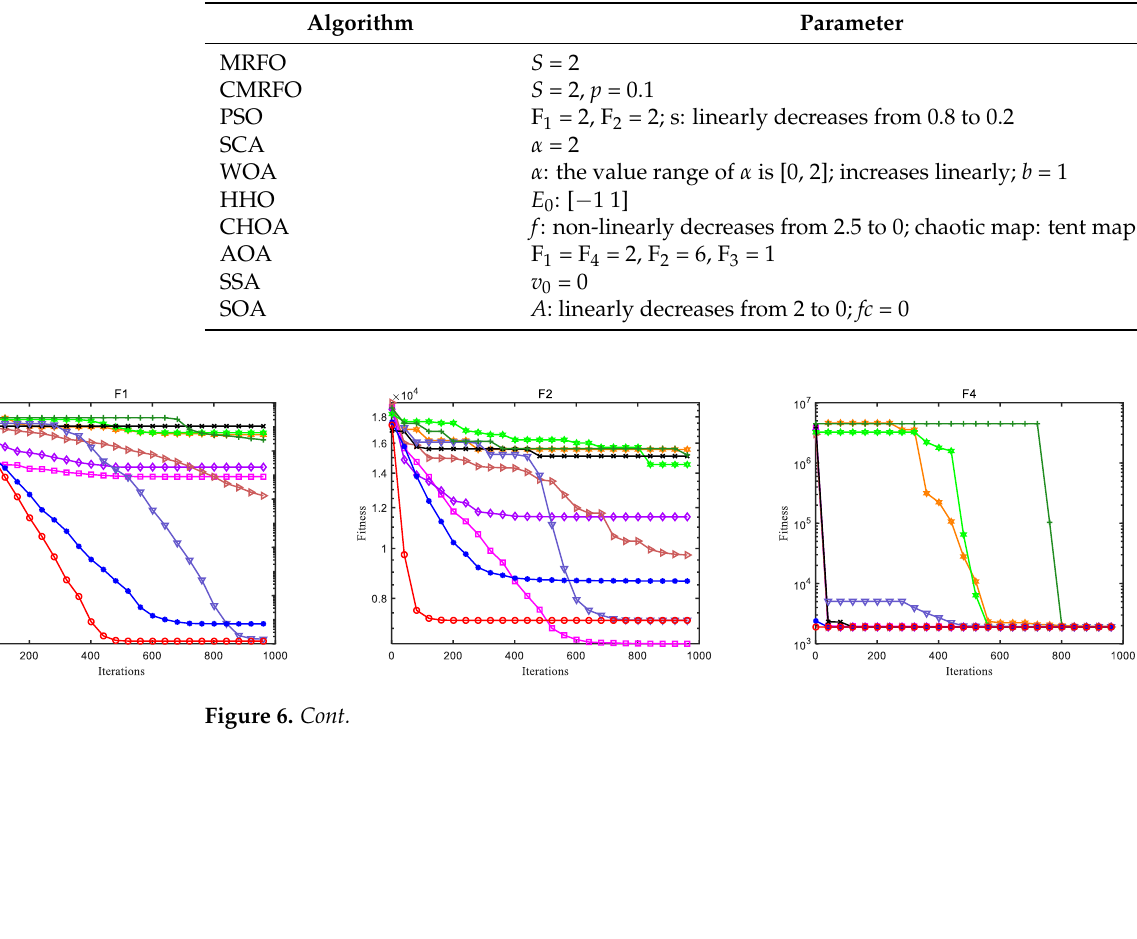
Table 8. Parameter settings of algorithms.